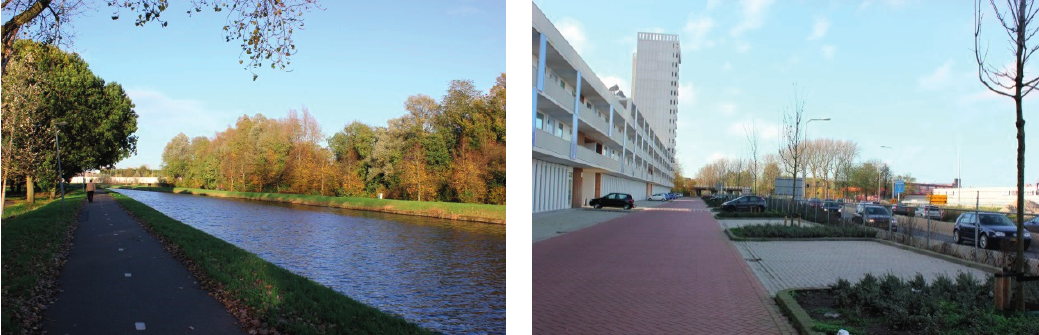
Figure 2. Impressions of green spaces in the two neighborhoods: Green space next to the highway in Corpus-Noord ( left ); and the highway next to the residential area in De Hoogte ( right